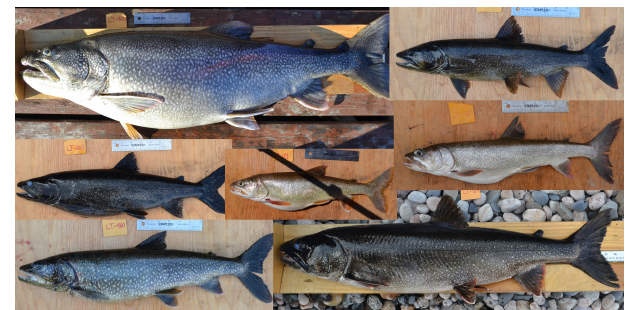
Fig. 4 . Collage of photographs of various lake trout taken in June 2013 and shown to Cree First Nation fishing experts as part of semidirective